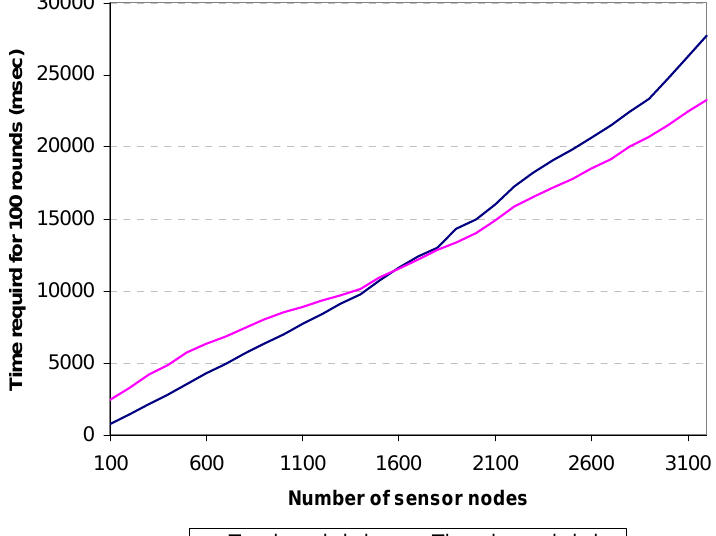
Figure 17. Timing differences between two-layered and three-layered